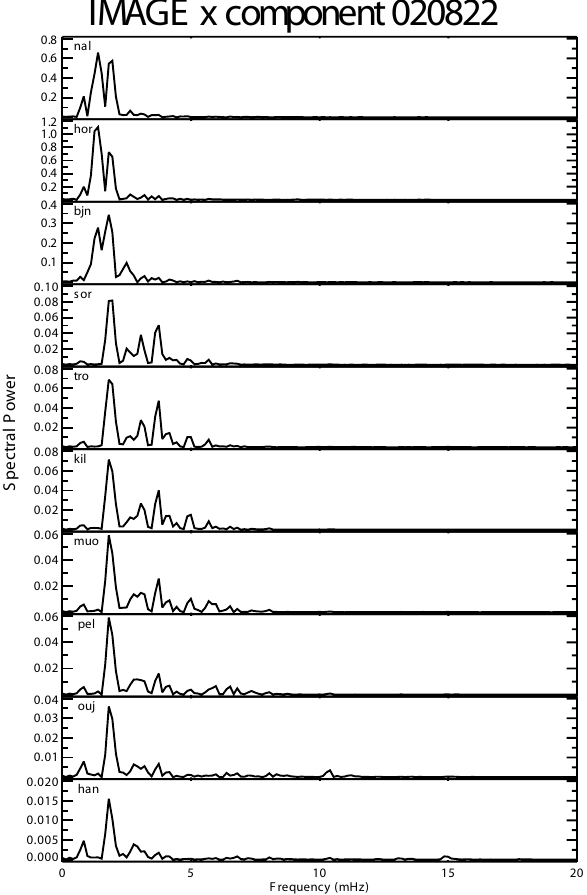
Fig. 11. Fourier spectra of X -component IMAGE magnetometer data on 22 August 2002 for 10:00–12:00 UT, bandpass filtered be- tween 1000–20s.